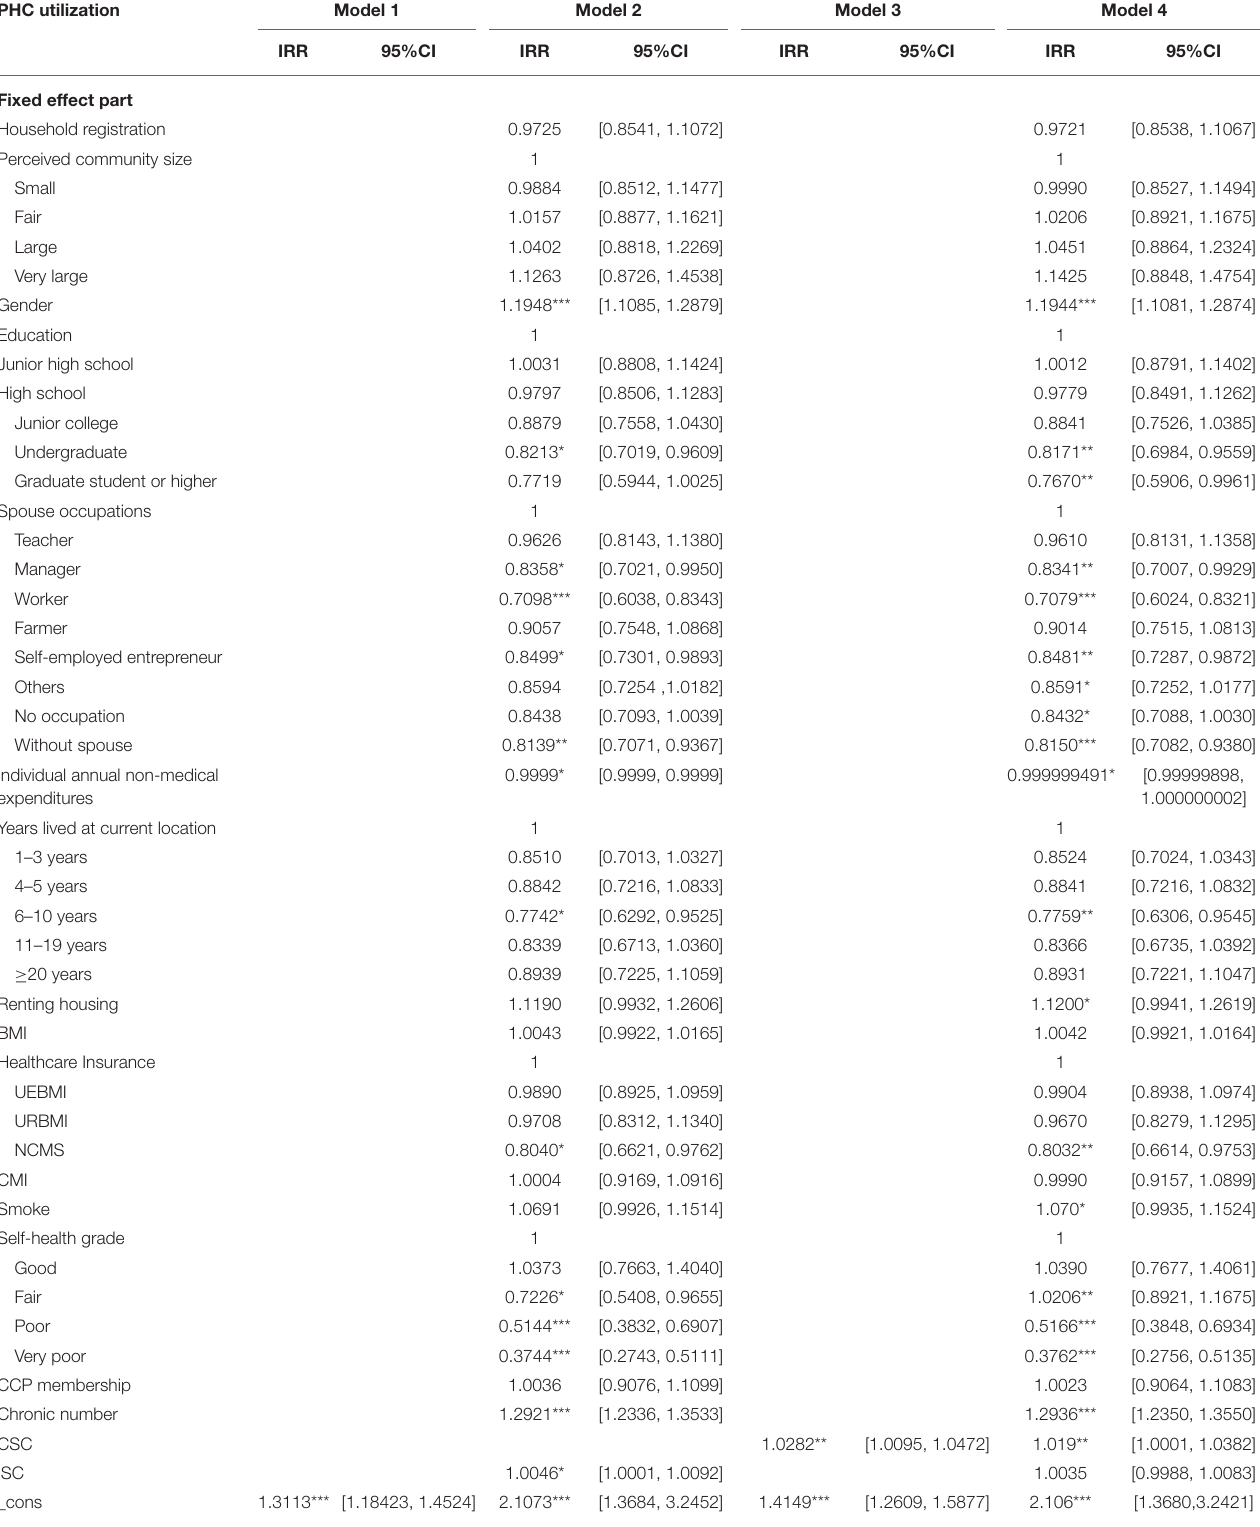
TABLE 3 | Multilevel regression analysis of factors associated with PHC